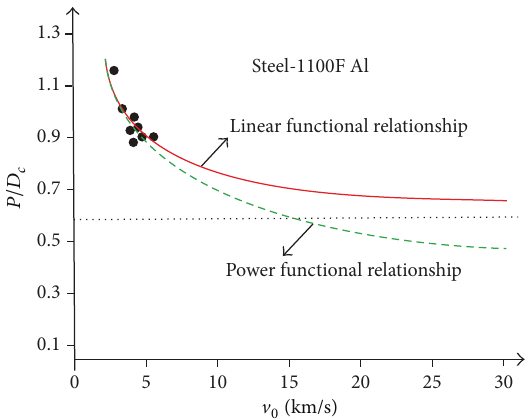
Figure 4: Comparison of the linear and power velocity